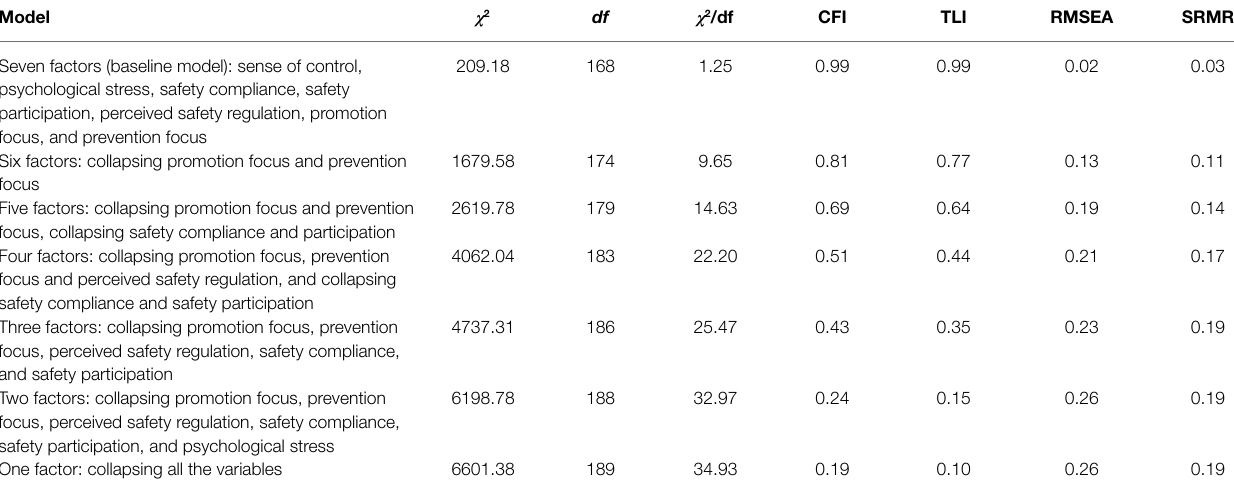
TABLE 1 | Confirmatory factor analysis for testing structure validity. Model χ 2